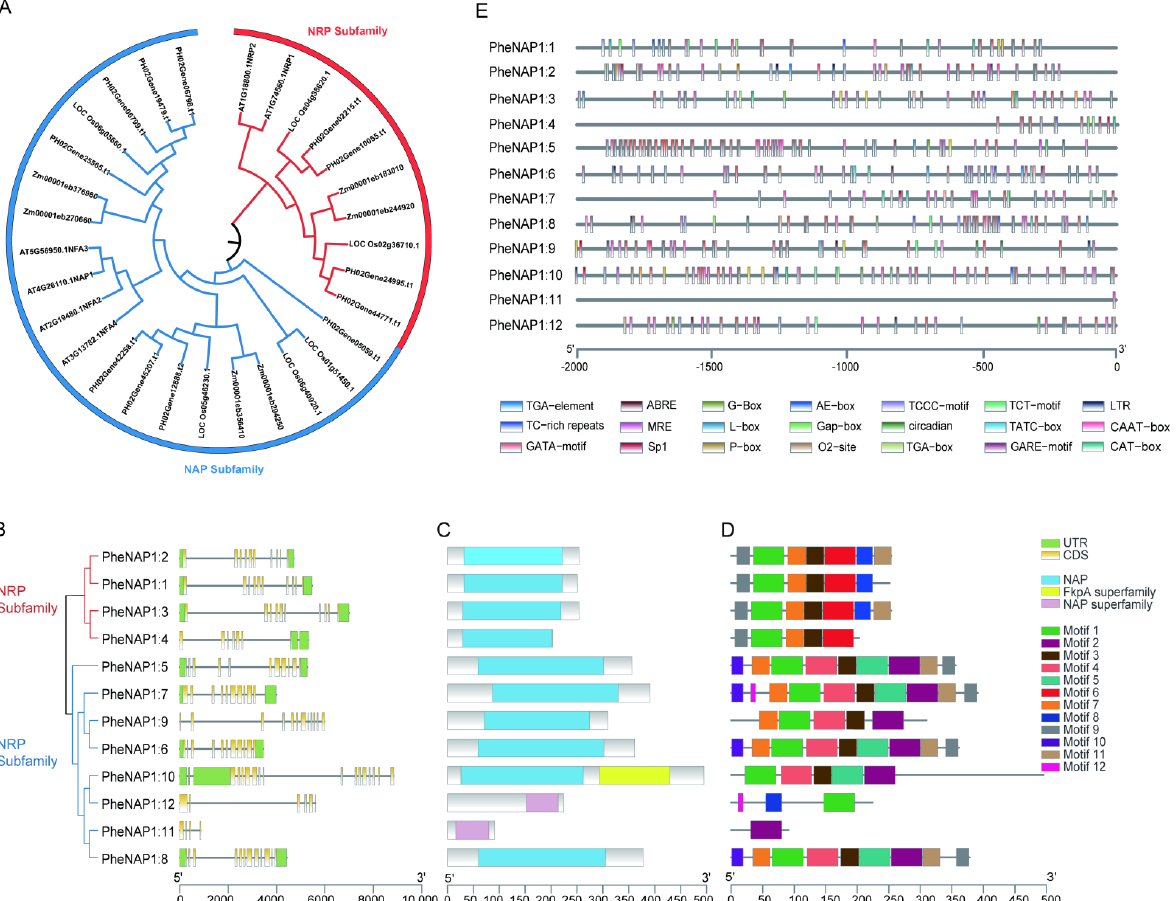
Figure 1. Evolutionary and structural analyses of the NAP1 family in Phyllostachys edulis . ( A ) Phy- logenetic analysis of NAP1. Phylogenetic trees (neighbor-joining) were constructed using all candi- date NAP1 proteins from Phyllostachys edulis , Oryza sativa , Zea mays, and Arabidopsis thaliana . The